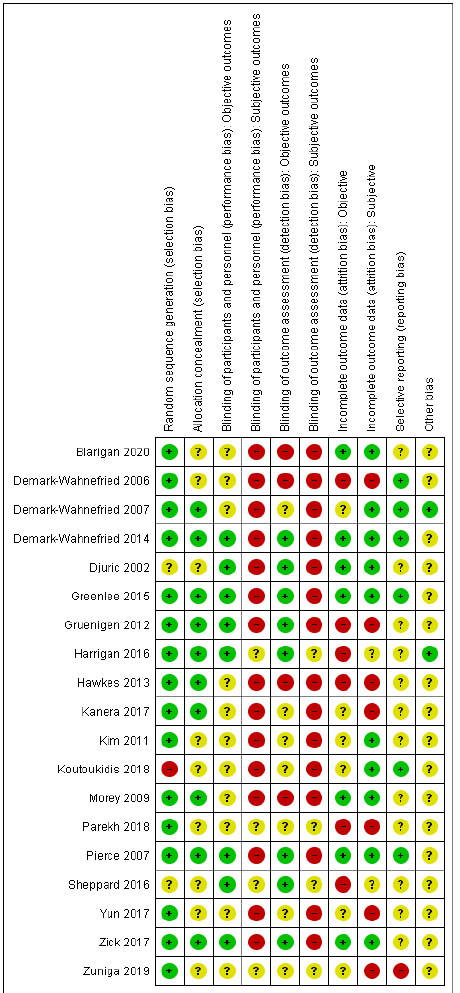
Figure 2. Risk of bias summary for each included study. Note: green (+) – low risk of bias, red (-) – high risk of bias, yellow (?) – unclear risk of bias.